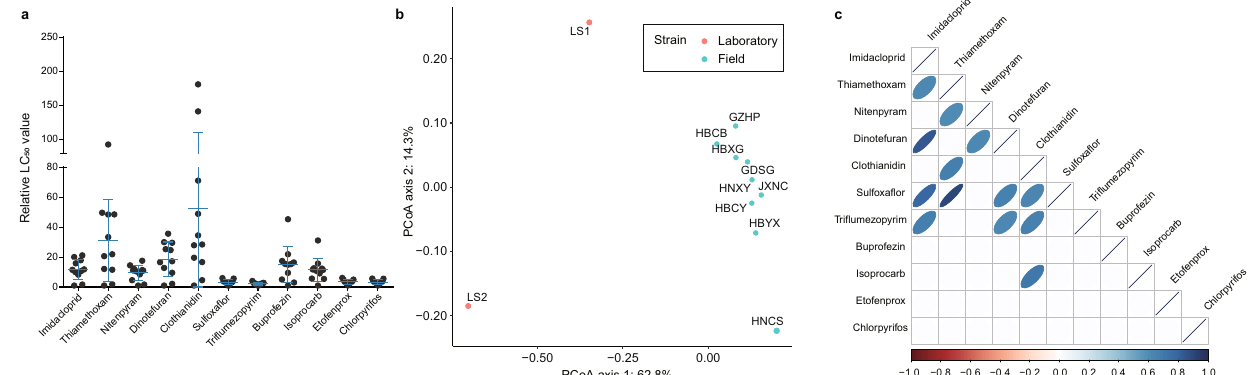
Fig. 2 The difference in insecticide susceptibility among 11 strains of Nilaparvata lugens . a Variation of susceptibility among different insecticides in different strains of N. lugens . b PCoA based on Bray – Curtis distance of the susceptibilities of laboratory and fi eld strains to insecticides. The color of points indicates the different sources of N. lugens . c Spearman correlation between LC 50 of different insecticides among 11 strains, correlations are based on linear Spearman correlation coef fi cients. The fi ll color of the ellipses indicates the strength of the correlation ( r ) and whether it is negative (red) or positive (blue). A higher absolute value will show a narrower area of ellipses down to a line ( r = 1). Only signi fi cant correlations with P < 0.05 are shown. If the correlation is not signi fi cant, the box was left